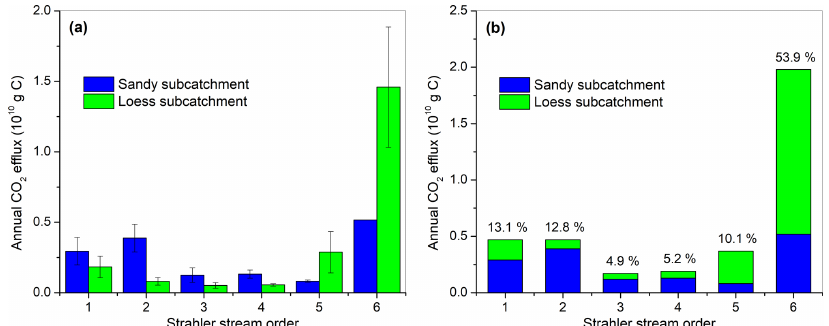
Figure 4. Longitudinal changes in CO 2 emissions along stream order in (a) the sandy subcatchment and the loess subcatchment and (b) the entire Wuding River catchment. The percentage above each order in (b) represents the proportion of CO 2 emissions from that order streams to the total CO 2 emissions. Error bars denote the standard deviation ( ± 1SD).